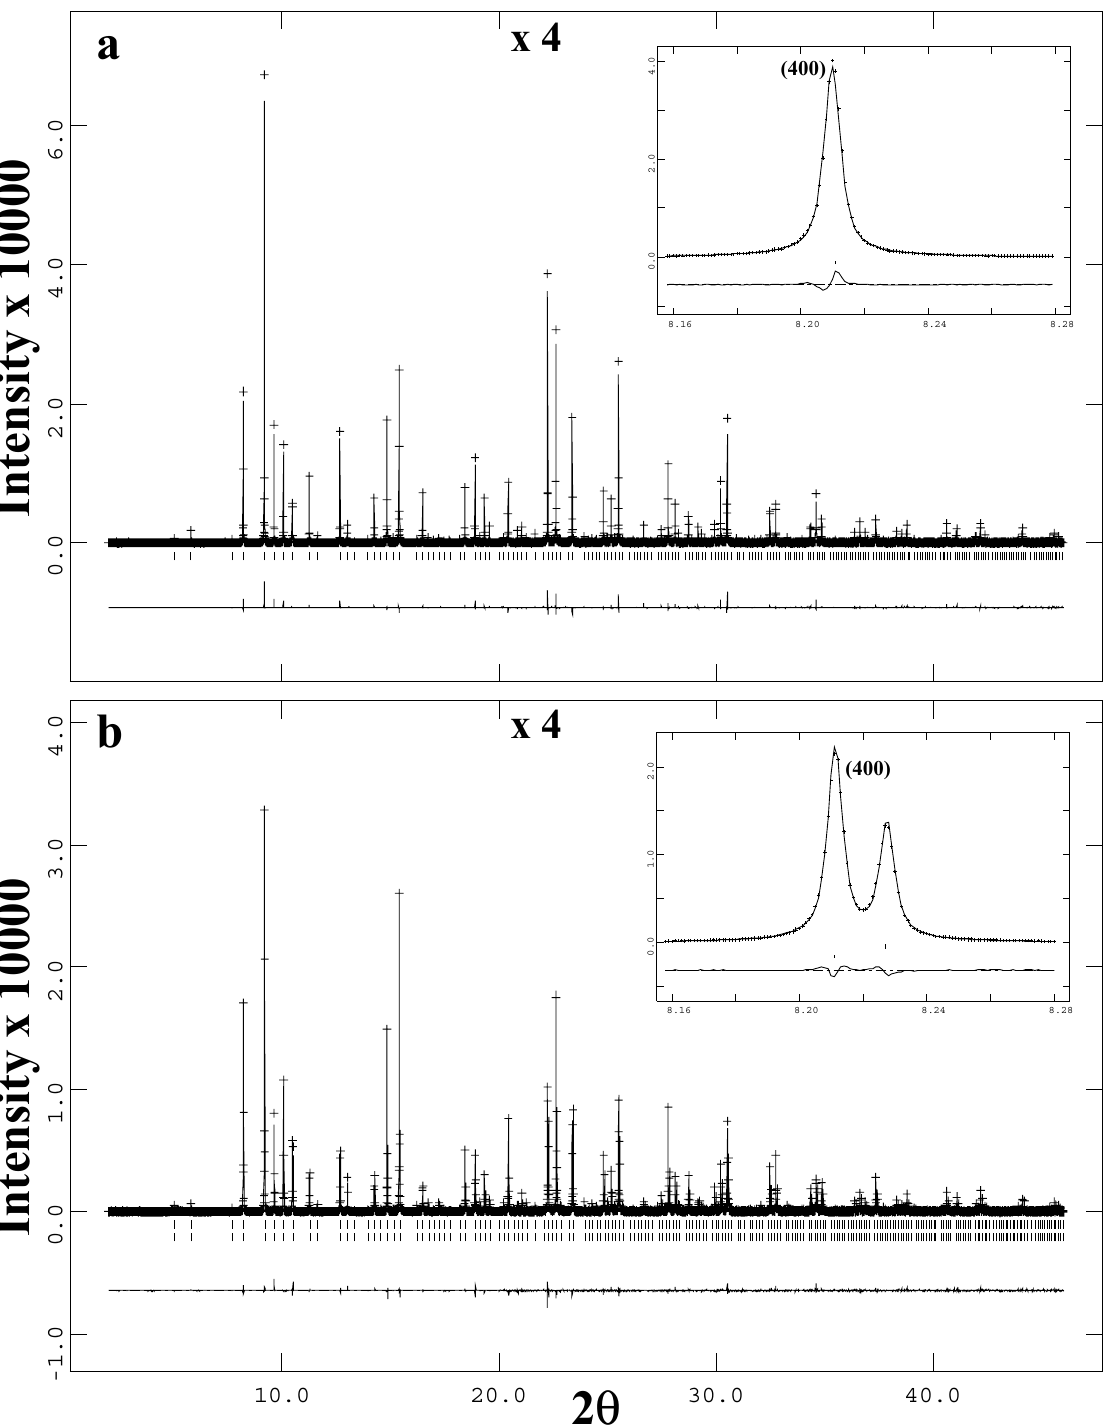
Figure 3. Full HRPXRD traces for both pyrope samples together with the calculated (continuous line) and observed (crosses) profiles. The difference curve ( I obs − I calc ) is shown at the bottom. The short vertical lines indicate allowed reflection positions. The intensities for the trace and difference curve that are above 20° 2 θ are multiplied by 4. Inserts show that the (400) reflection is not split in sample 1 in ( a ) but clearly split into two in sample 2 in ( b ).